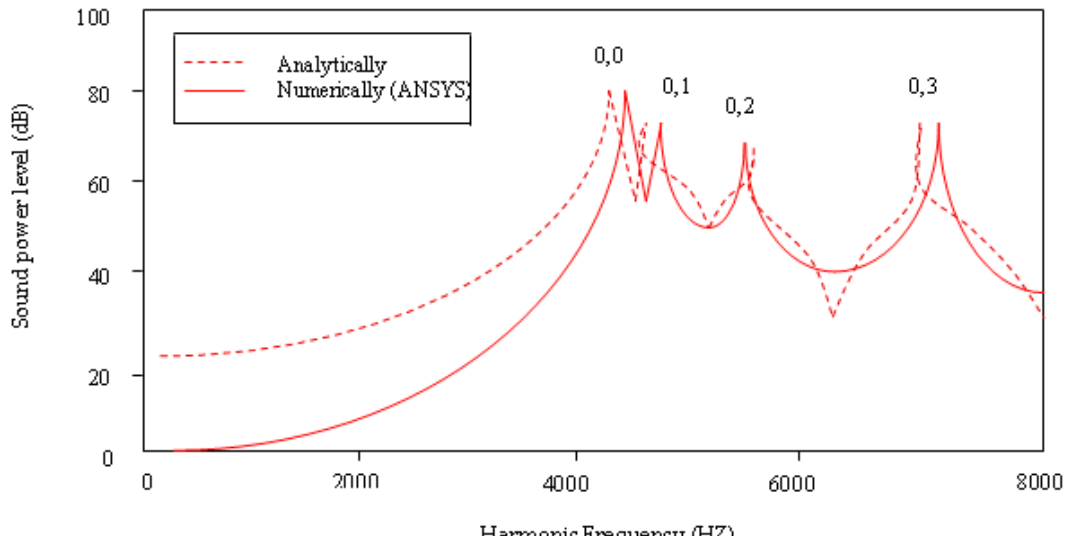
Figure 9. Comparison of sound power level analytically and numerically for annular plate attached with 4 concentric stiffener patches and having parabolic decreasing thickness variations (Case I) for taper ratio T x = 0.75.